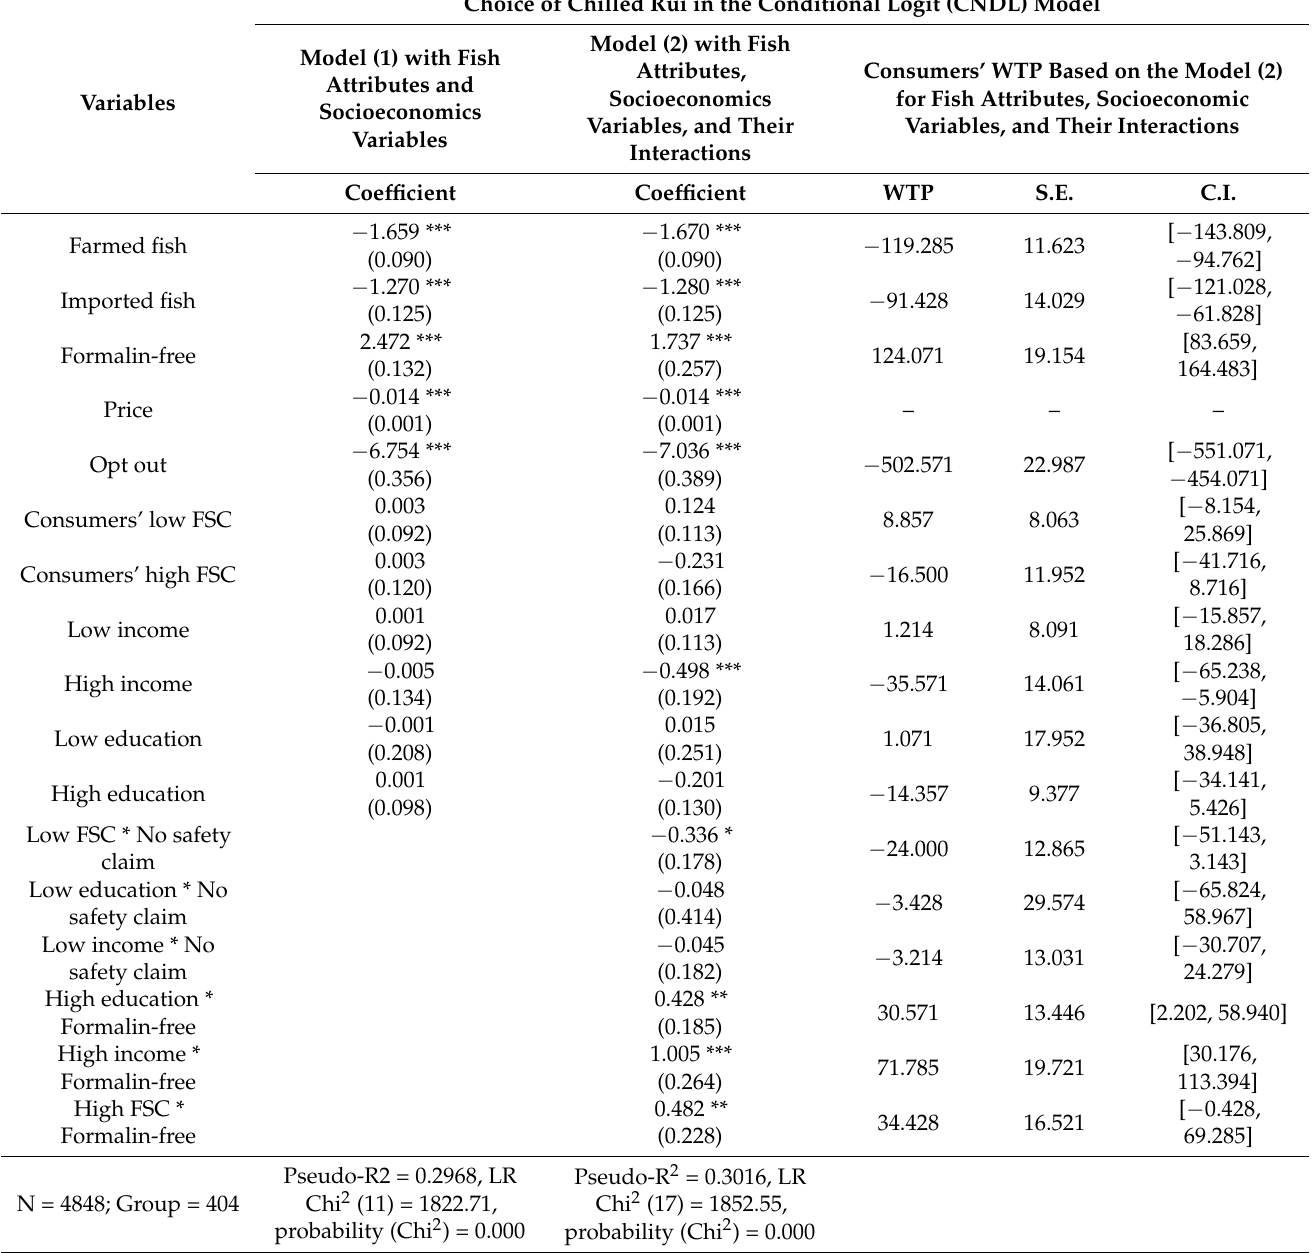
Table 5. Conditional choice model estimate with fish